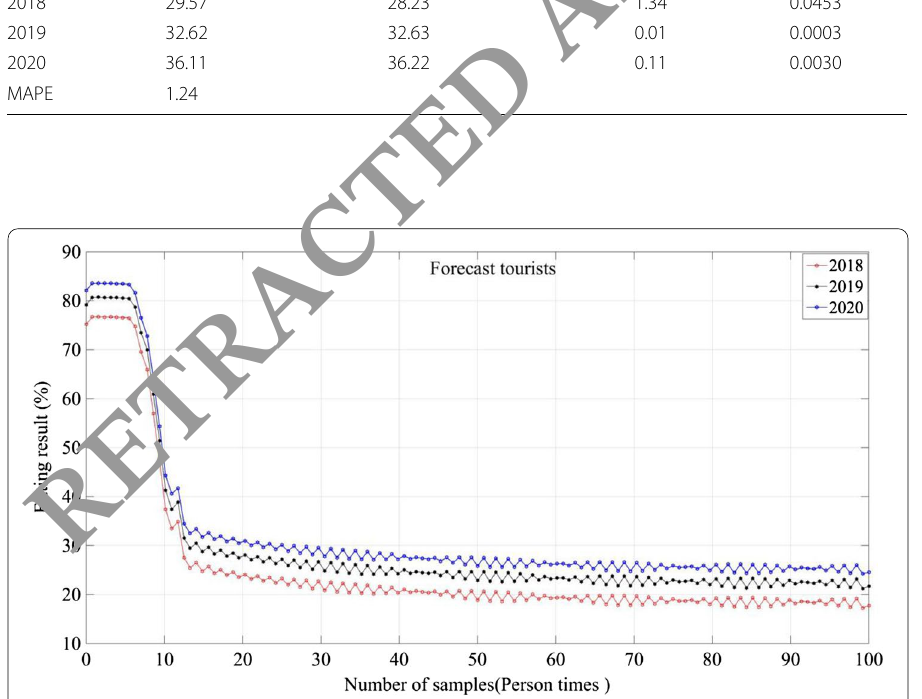
Table 5 Comparison of actual and predicted domestic tourist arrivals from 2018 to 2020 Years